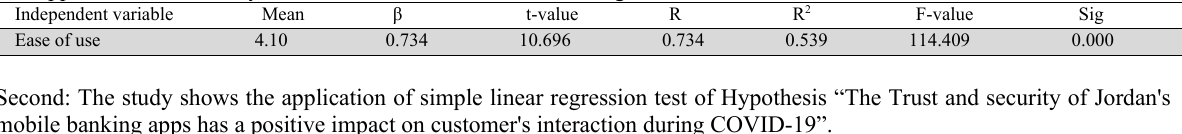
Mean β t-value R R 2 F-value